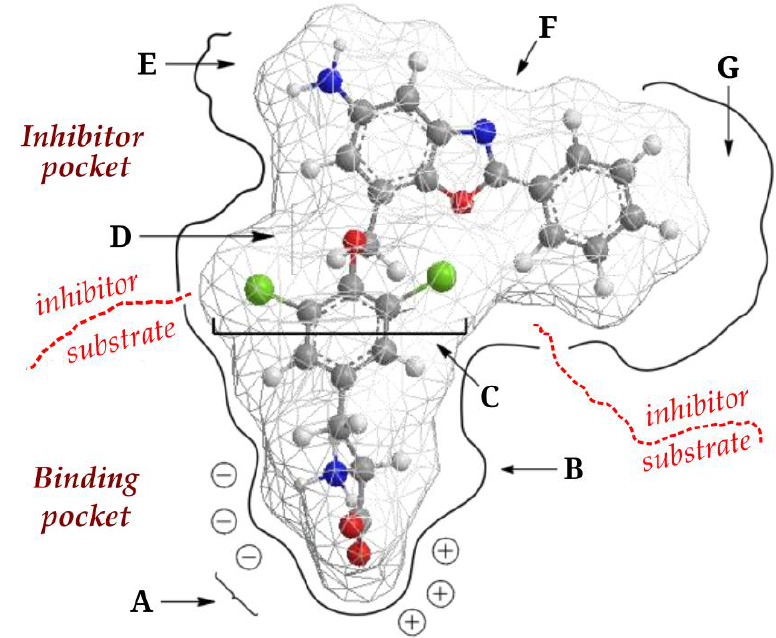
Figure 4. A model structure of a potent LAT1 inhibitor (JPH203) at the LAT1 binding pocket and its key characteristics to be a LAT1 substrate (A–C) or a LAT1 inhibitor (all) [46]. Legends: Regions: A. amino acid moiety; B. α -carbon, C. aromatic ring with halogen substituents (green balls) on meta positions; C. and D. “substrate-inhibitor interface”; E. amine group on benzoxazole ring; F. nitrogen atom of benzoxazole ring; and G. phenyl ring. Atoms: grey (carbon), white (hydrogen), red (oxygen), blue (nitrogen), and green (halogen, as Cl or I).